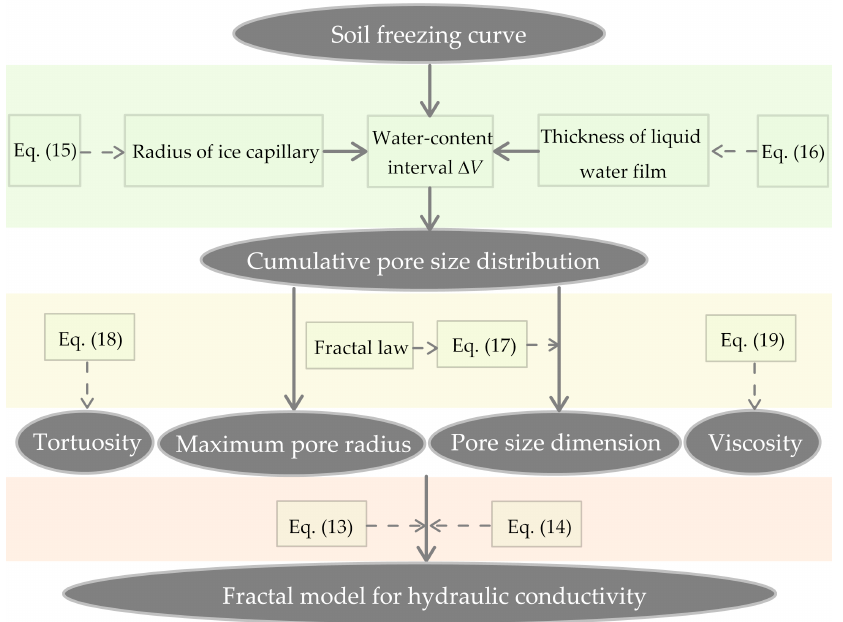
Figure 4. Flow diagram of fractal model building.